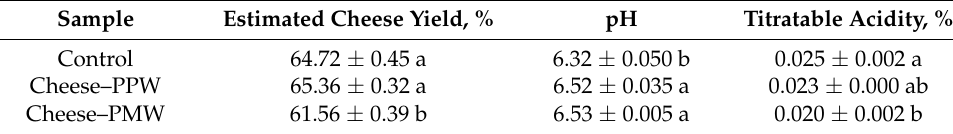
Table 5. Yield and physico-chemical properties of cheese containing pomegranate extracts. Sample